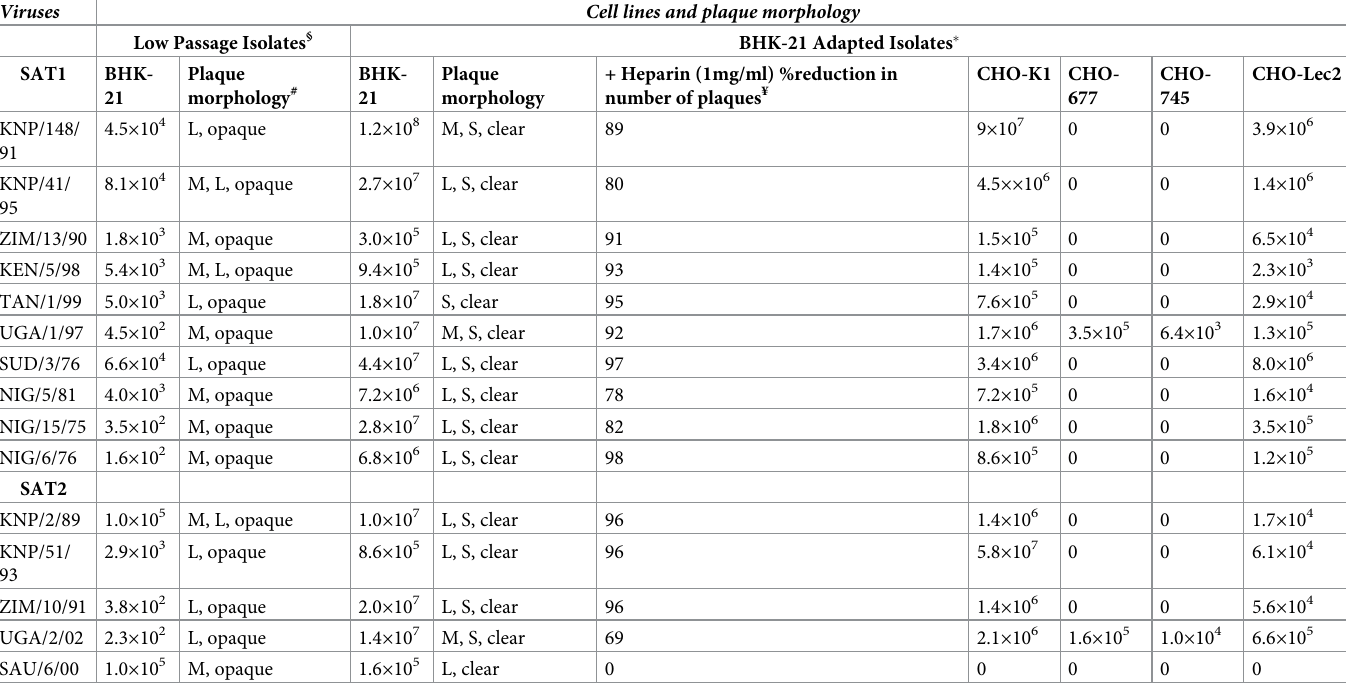
Table 1. Cytolytic passaging of the SAT1 and SAT2 viruses in BHK-21 cells: the plaque morphologies and their titres in PFU/ml on BHK-21, CHO-K1, CHO-677, CHO-745 and CHO-Lec2 cells are indicated. Viruses Cell lines and plaque